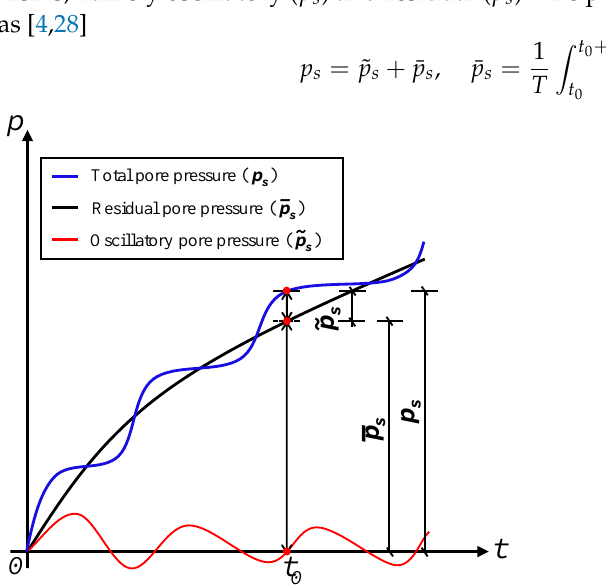
Figure 2. Development of oscillatory and residual pore